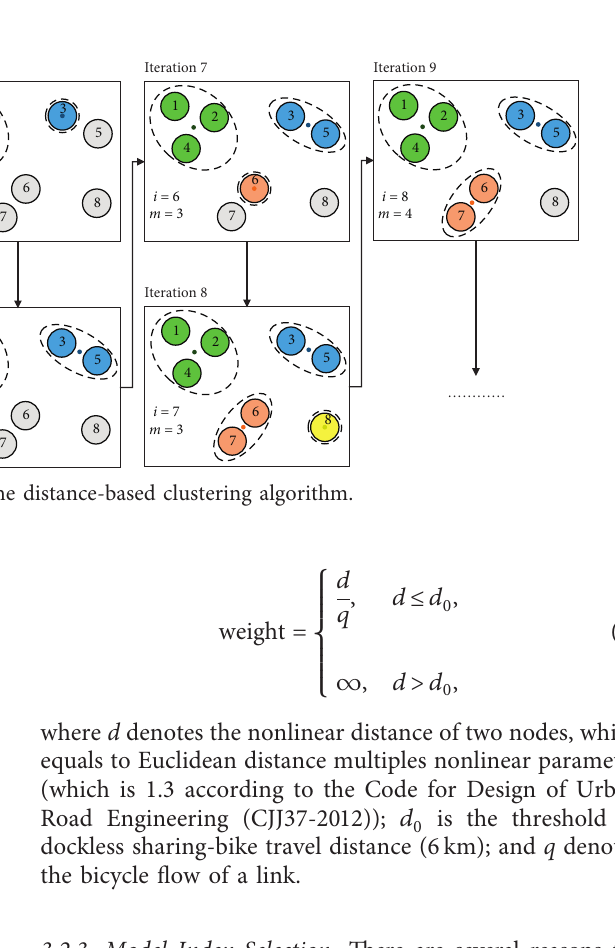
Figure 1: Distribution of dockless sharing bikes: travel distance